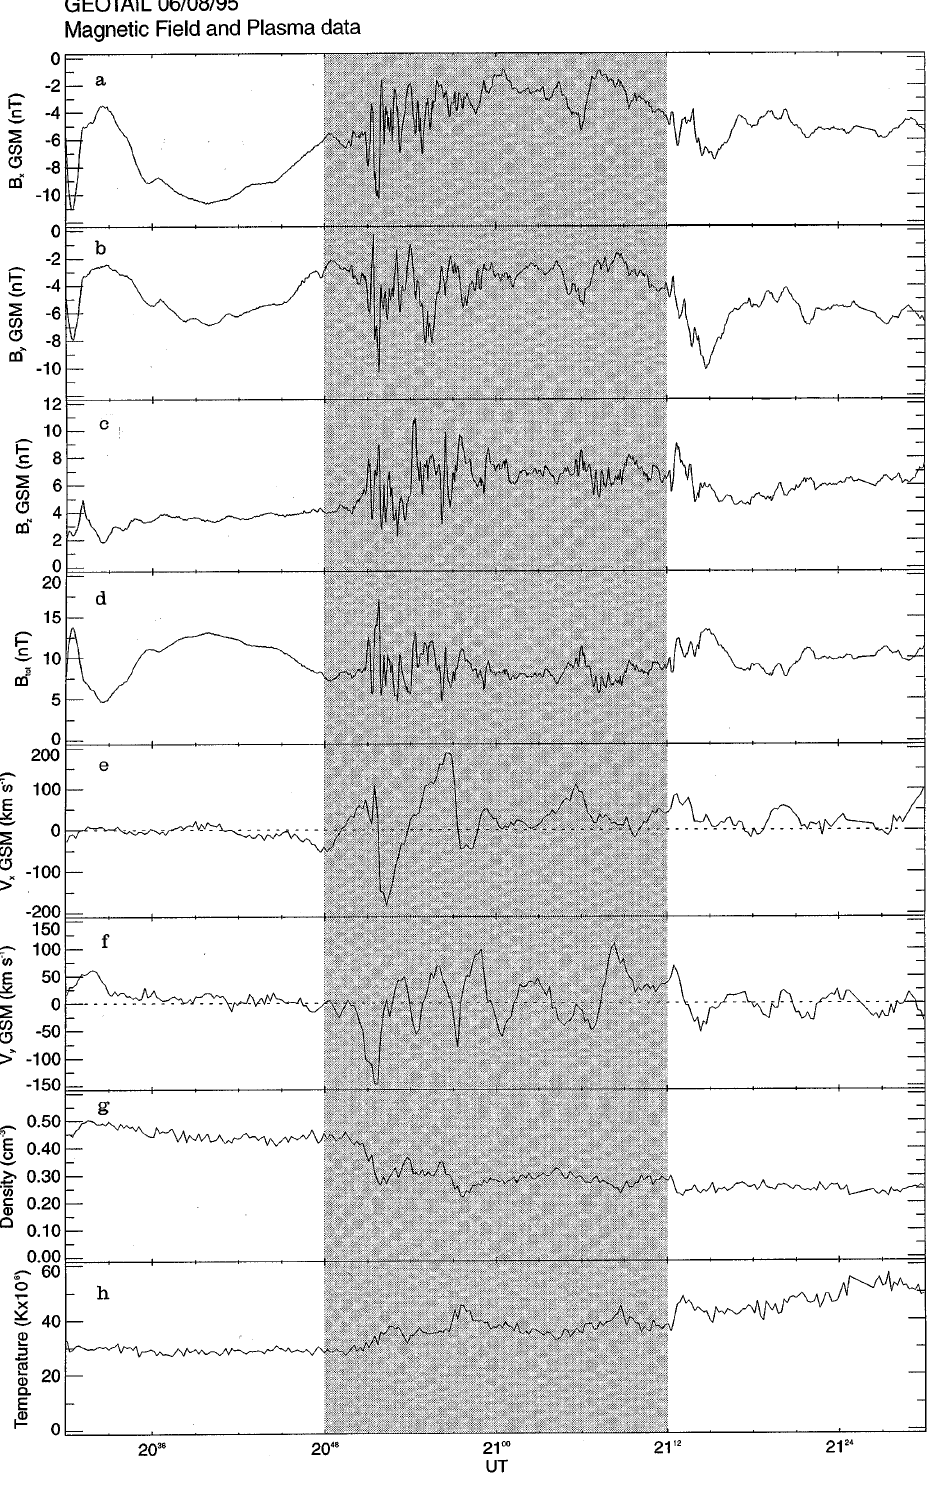
Panels a and b of Fig. 5 present the ionospheric convection velocity from the CUTLASS Finland radar. Positive Doppler velocity represents flow toward the radar (equatorward flow). A greyscale representation of the line-of-sight velocity from beam 9, and a time series plot of beam 9 range gate 25 are displayed. This